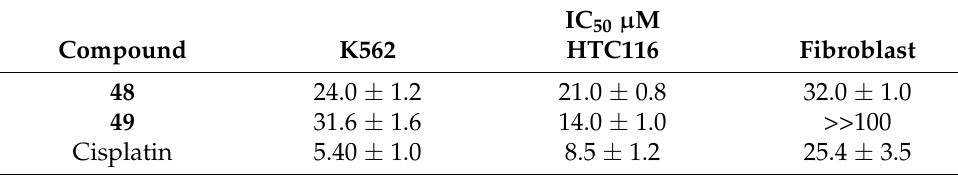
SD. Cisplatin was used as a reference compound. Cisplatin was used as a reference